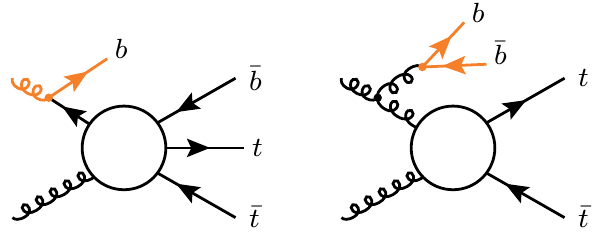
Fig. 1 Sample t ¯ tb ¯ b diagrams with IS (left) and FS (right) g → b ¯ b splittings. In NLOPS simulations of inclusive t ¯ t production in the 5F scheme the black subtopologies are described in terms of tree matrix elements, while the orange lines correspond to parton shower emissions